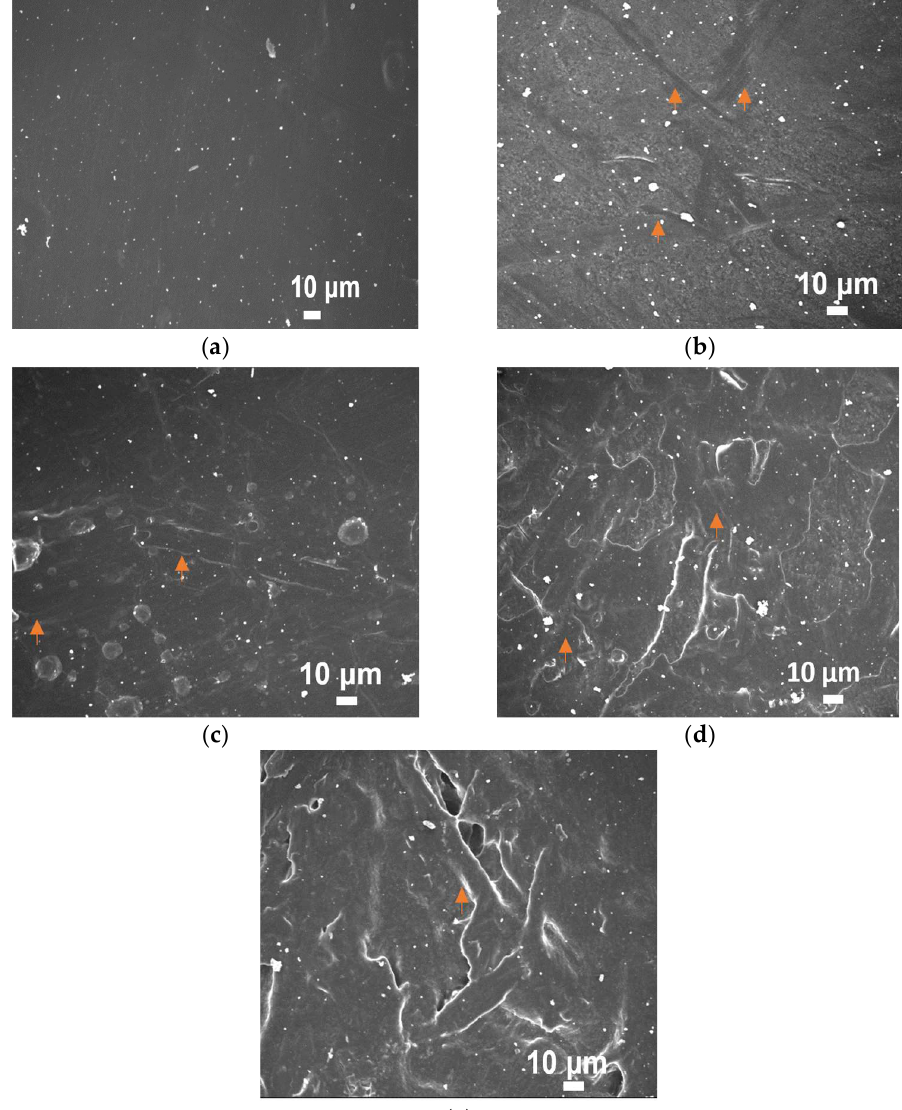
Figure 10. Microphotographs of ( a ) r-HDPE and r-HDPE + ( b ) 10% wt., ( c ) 20% wt., ( d ) 50% wt., and ( e ) 75% wt. HF + JC composite materials. Magnification ×500.